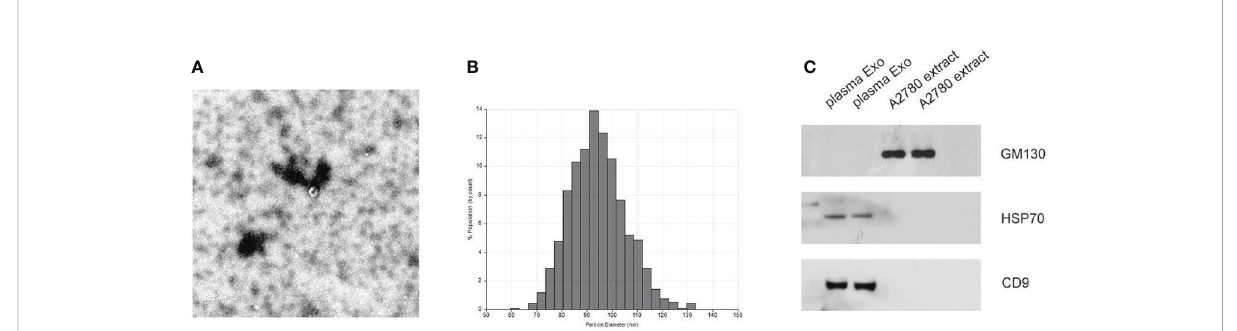
FIGURE 1 Identi fi cation of isolated exosomes. (A) TEM image showed the data of exosomes from EOC plasma samples with 50 – 150 nm diameter. (B) Distribution of exosomes with 50 – 150 nm diameter; the samples were obtained from EOC plasma samples based on the qNano system. (C) HSP70, CD9, and GM130 as common exosome markers, were analyzed by western